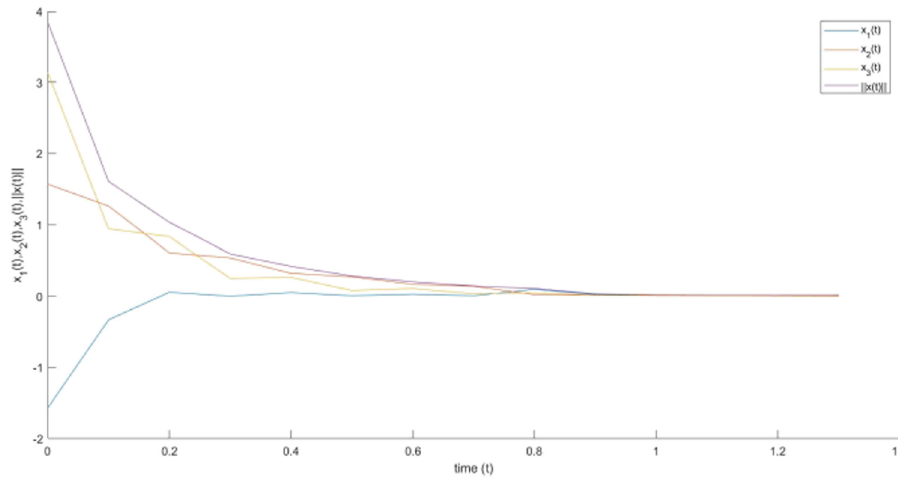
Figure 3: The exponential convergence of the solution of systems ( 40 ) – ( 42 ) to zero under ETIC control ( )